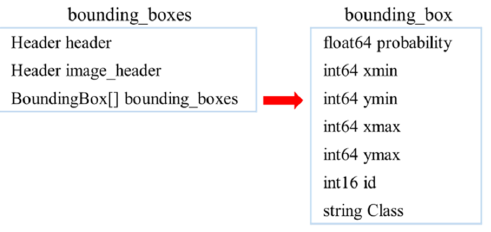
Figure 7. Data structure for bounding boxes and bounding box.